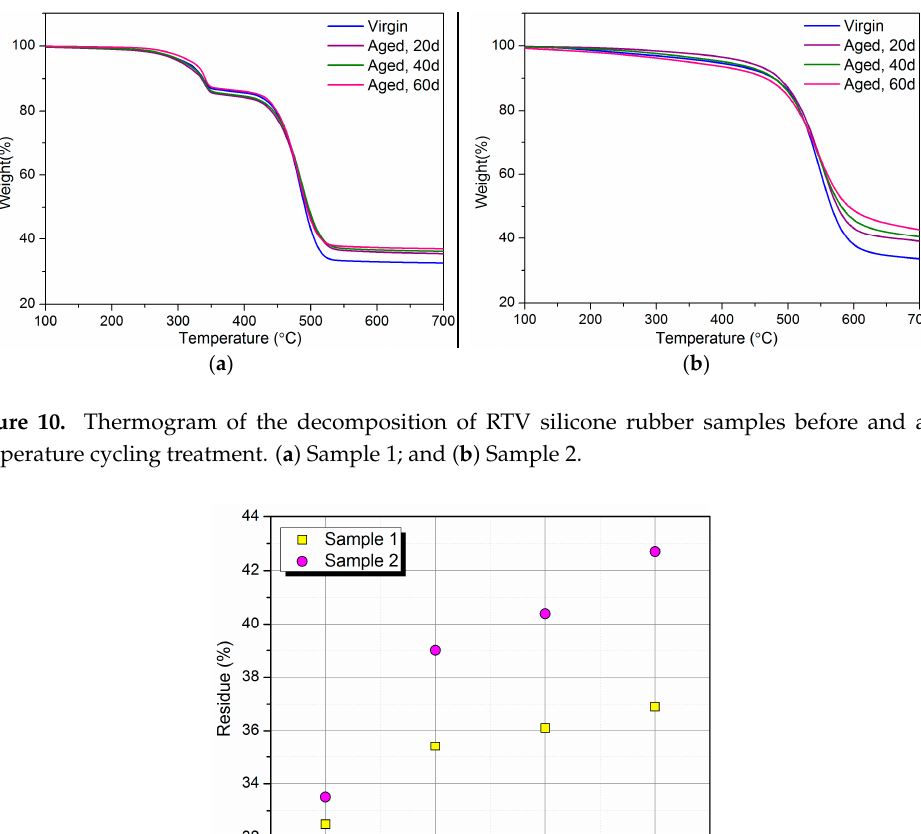
Figure 11. Residue data of samples from TG curves at 700 °C. Table 2. Boiling points of linear and cyclic silicone oligomers. M: (CH 3 ) 3 SiO 1/2 –, and D: –(CH 3 ) 2 SiO– [8]. Linear Structure Boiling Point (°C) Cyclic Structure Boiling Point (°C)